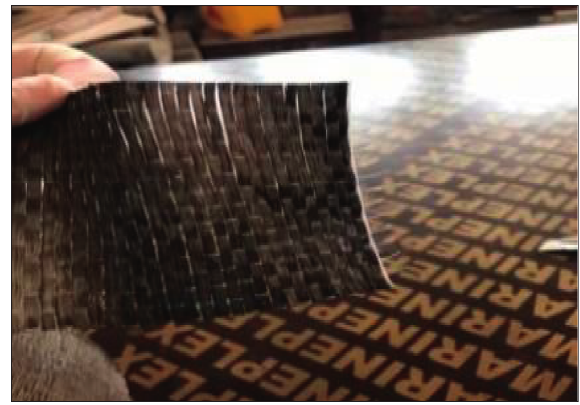
Figure 1: Unidirectional woven carbon